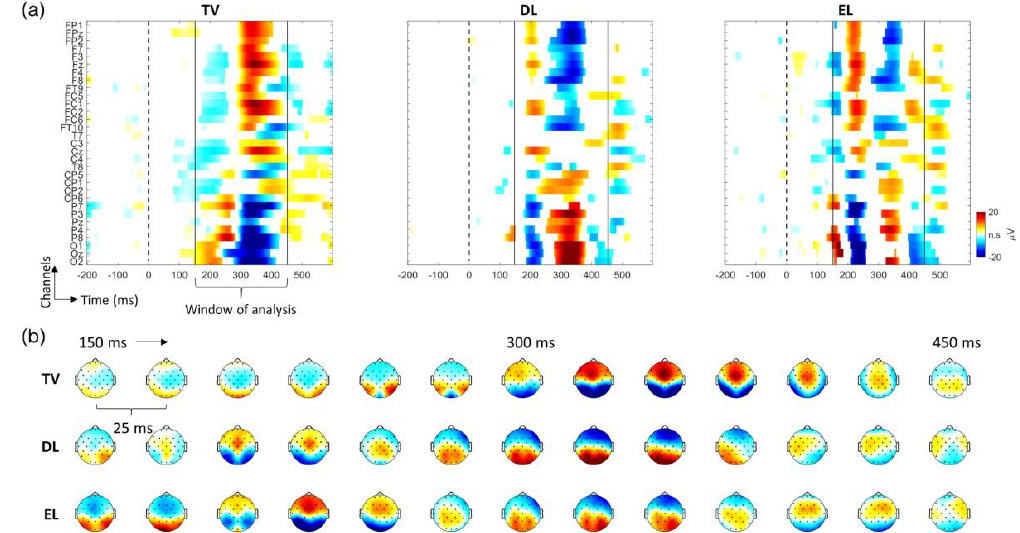
Figure 3. ( a ) Time-channel ERP maps and ( b ) topological map of scalp. Color scale denotes significantly different ERP amplitude by the two-sample t -test on a sample-by-sample basis ( p < 0.01). ( a ) The vertical solid dark lines denote the window of analysis from 150 to 450 ms. ( b ) An individual topological map indicates a time instant within the window of analysis, which is represented as the interval of 25 ms.